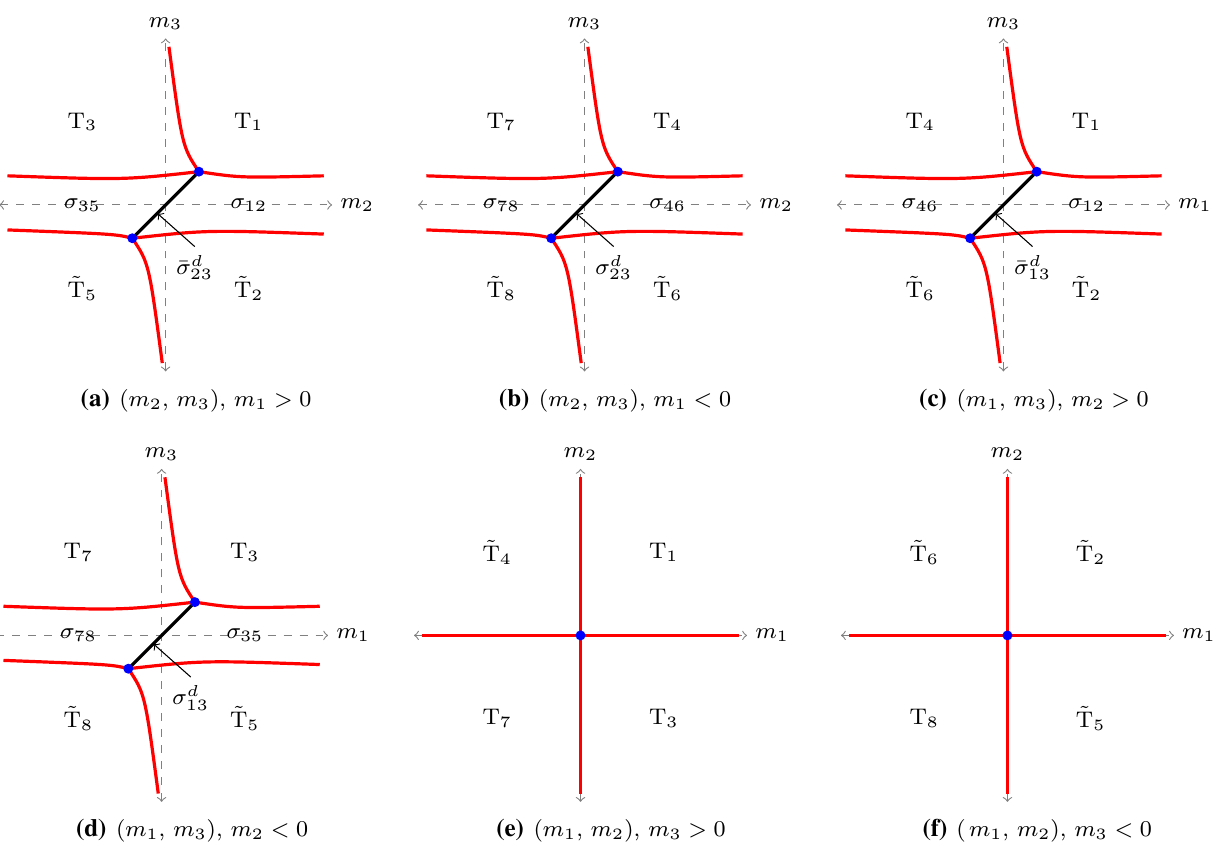
Fig. 14 Phases of SU ( N ) k + p ψ 1 + q ψ 2 + ( F − p − q )ψ 3 with 0 ≤ k < F / 2 − ( p + q